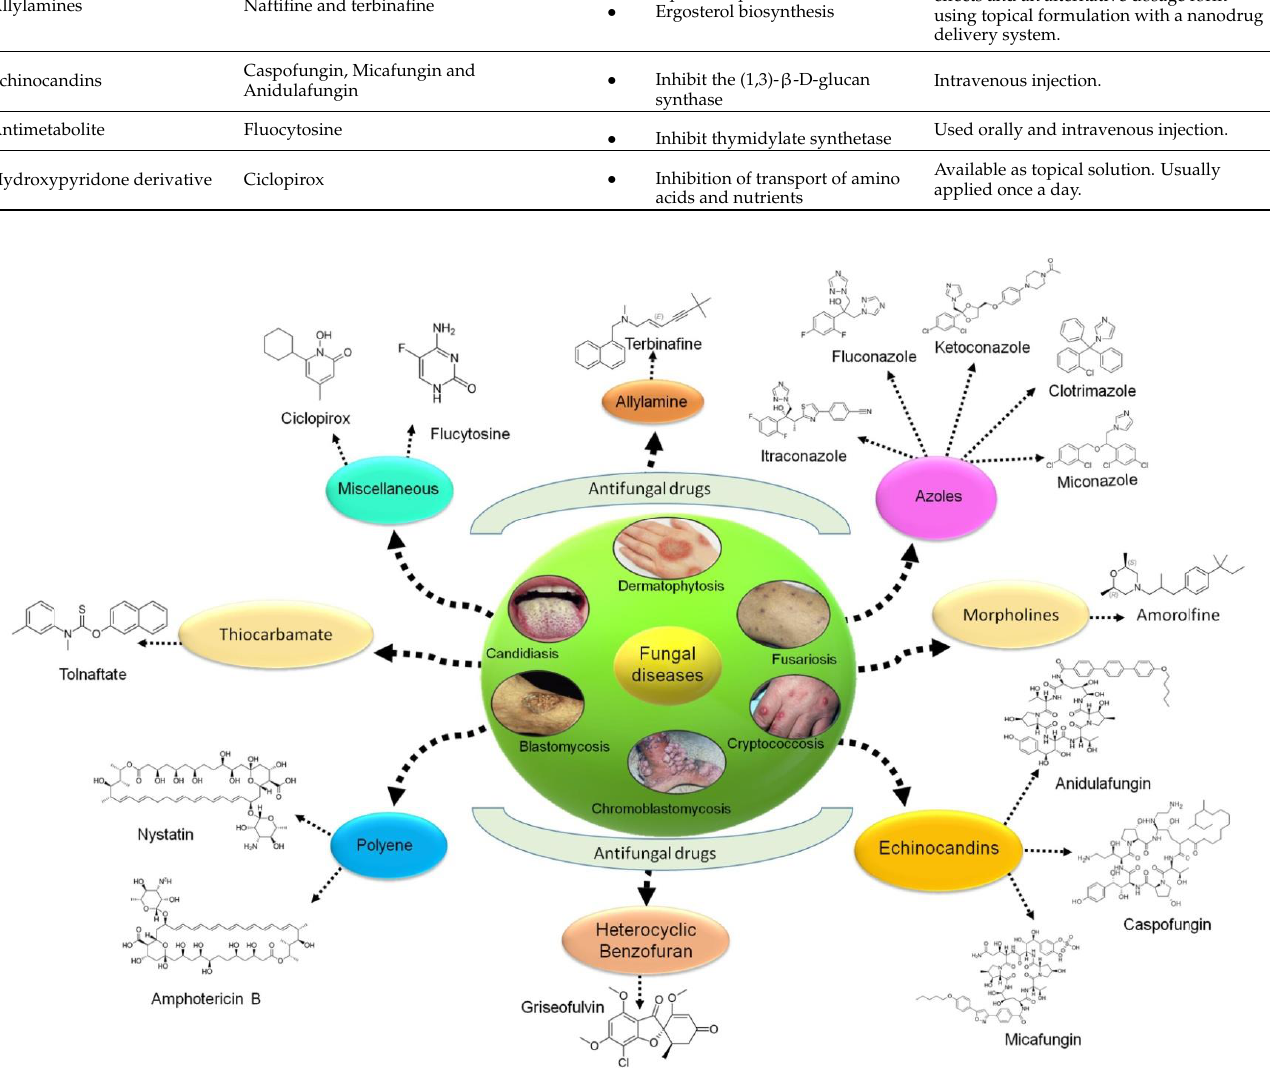
Figure 1. Various types of antifungal drugs currently used in